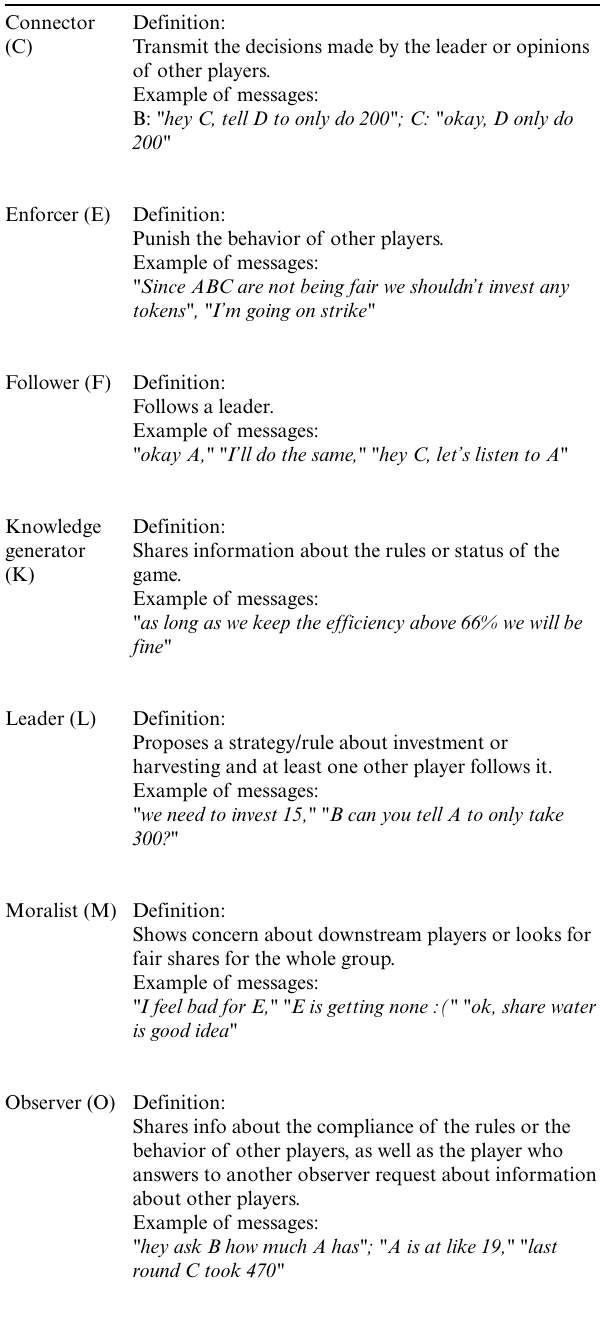
Fig. 1 . Screenshot of the experiment. The player’s position is indicated in green (in the figure, position C) and the other players’ positions are indicated in yellow. In this screenshot, player C’s gate is open, and all other players’ gates are closed. Participants located in positions A, B, C, D, and E need to make decisions whether to open or close their gate. The water is coming from the left of the